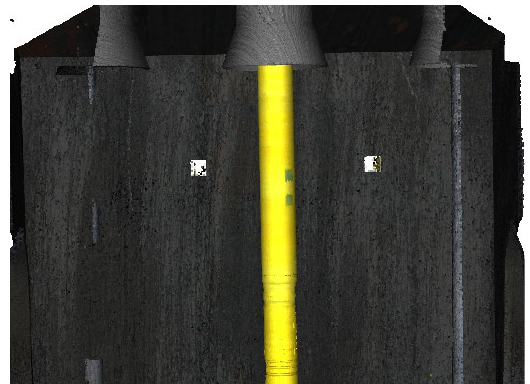
Figure 13. 3D textured mesh from stereo setup simulation.